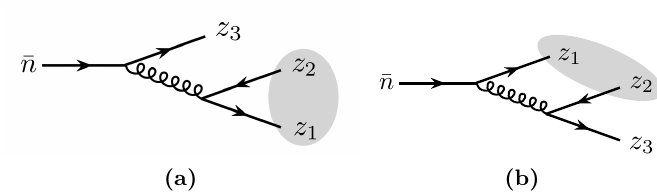
Figure 7. Two distinct OPE channels. In (a) we squeeze onto an on-shell gluon state associated with a 1 /θ 2 singularity in the OPE. This singularity must be reproduced by the OPE in the crossed channel shown in (b). This requires an infinite number of operators of increasingly high transverse spin, and leads to analyticity in transverse spin of the light-ray